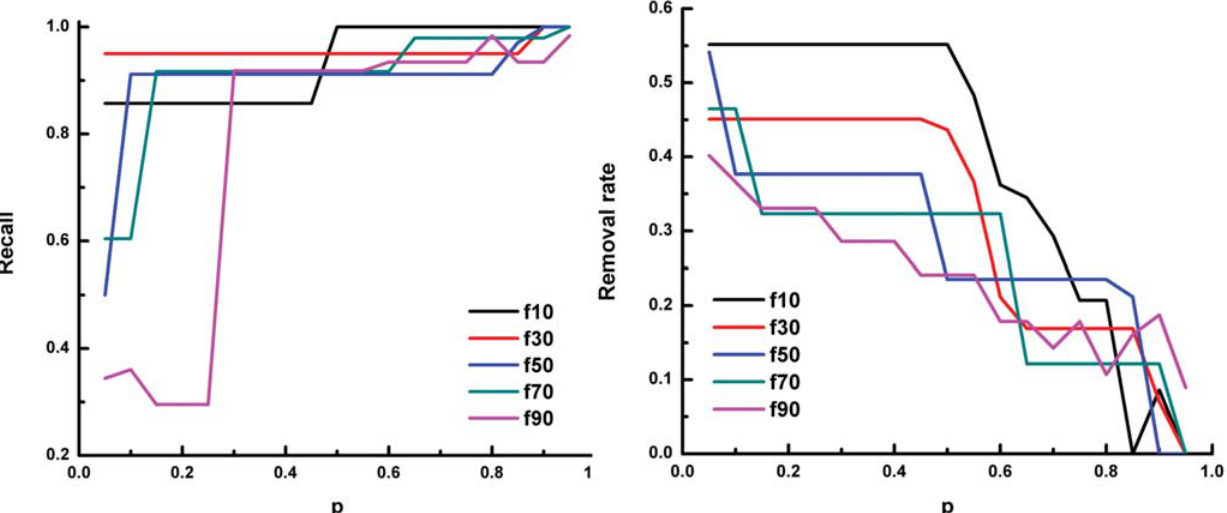
Fig 3. The recall and removal rate of prediction on Oct4-miRNA relationships using known regulation between Oct4 and protein-coding genes or miRNA genes. In each panel, the x-axis denotes the parameter p of SVMlight. The y-axis denotes the recall (left panel) and the removal rate (right panel) of the prediction, respectively. f10 means 10% of the known positive examples are put into the unlabeled data,and f30, (cid:3)(cid:3)(cid:3) , f90 mean 30%, (cid:3)(cid:3)(cid:3) , 90% of the known positive examples are put into the unlabeled data,